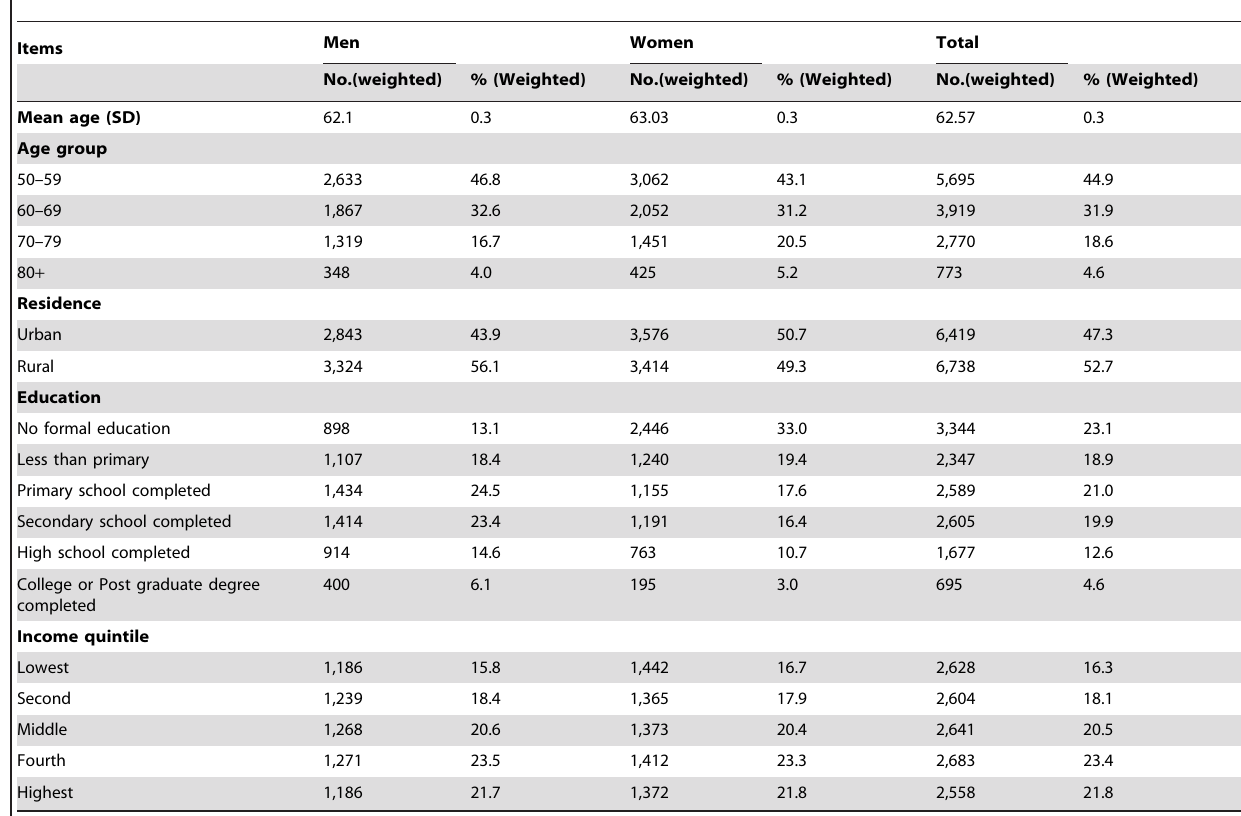
Table 1. Characteristics of the Study Population, SAGE China Wave